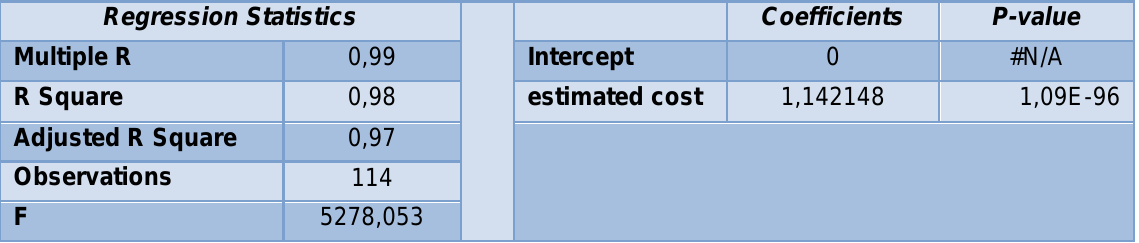
Table 6 Regression statistics of estimated cost vs. actual cost in road projects with cost less than $300000